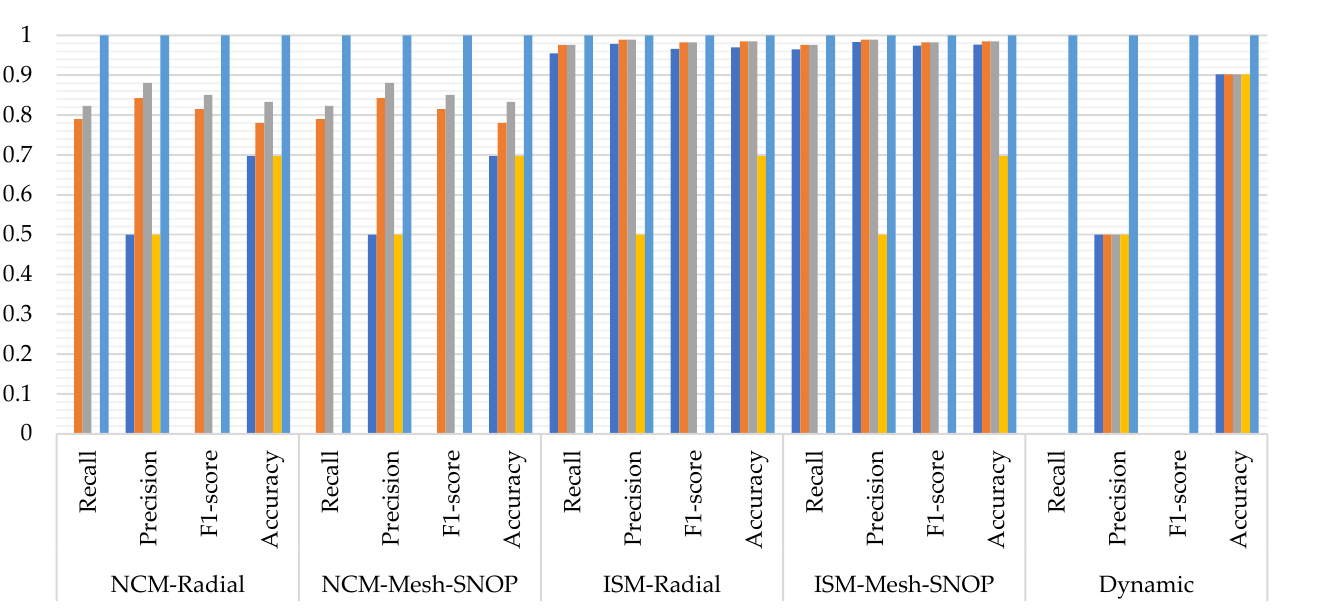
Figure 9. The performance of all MLTs during NCM, ISM, dynamic operation mode in terms of recall, precision, F1-score, and accuracy.